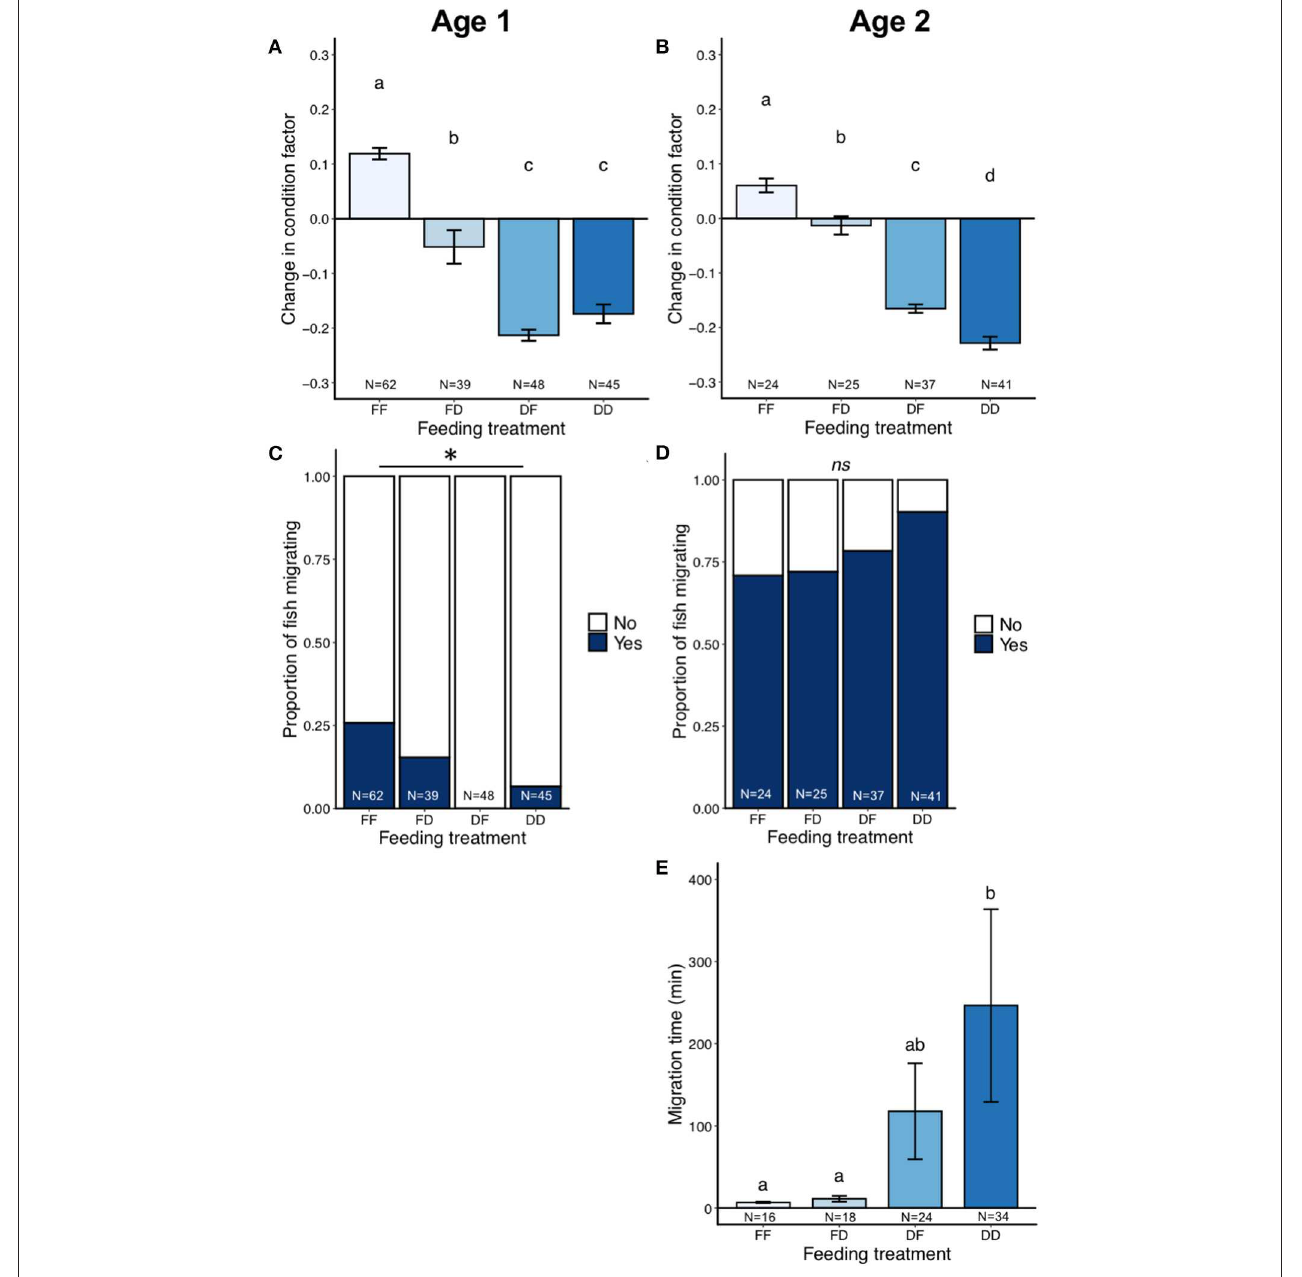
FIGURE 5 | Results from the small-scale field migration study (part two), showing change in condition factor (A,B) , proportion of fish migrating (C,D) , and migration time between antennas in the creek (E) for the age one and age two cohorts. Error bars represent ± 1 standard error of the mean. Different letters show statistical differences among treatment groups. * indicates P < 0.05. Note: too few age one fish migrated to test for effects of feeding on migration time.